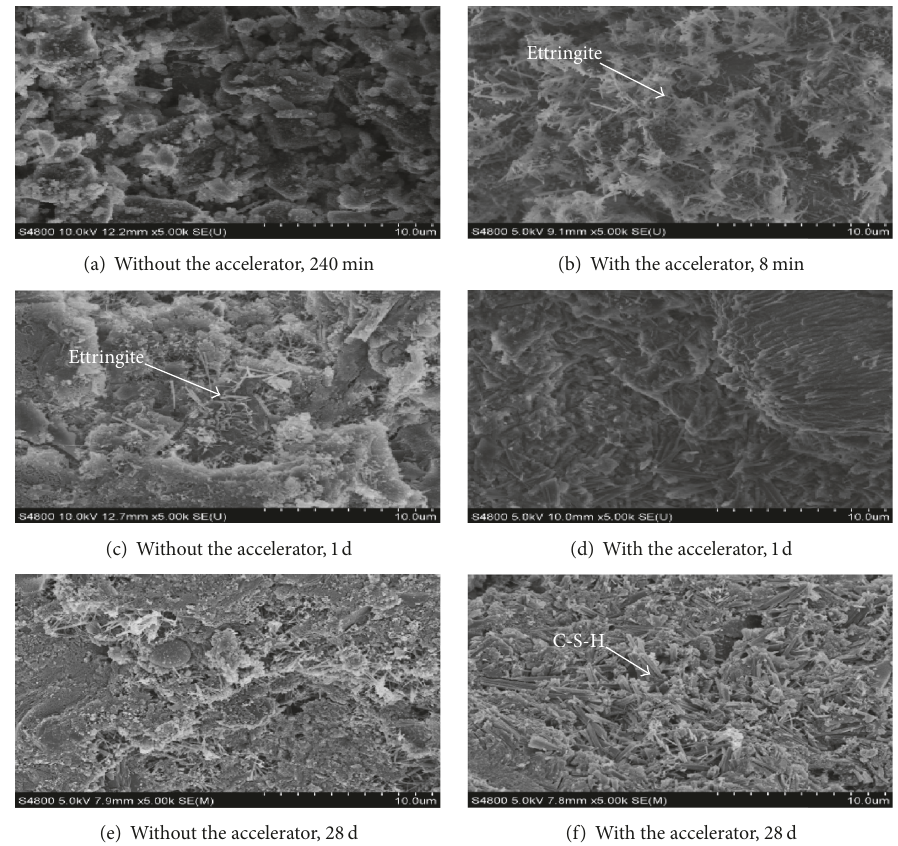
Figure 7: SEM images of hardened cement paste specimens with and without the